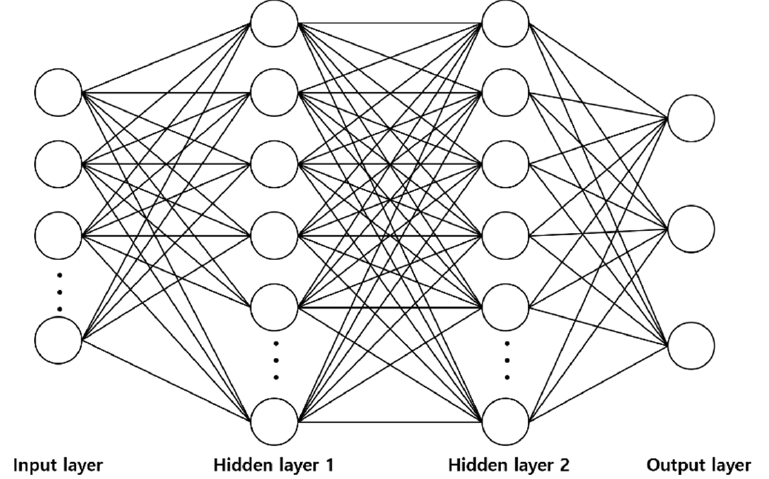
Figure 6. Structure of MNN.